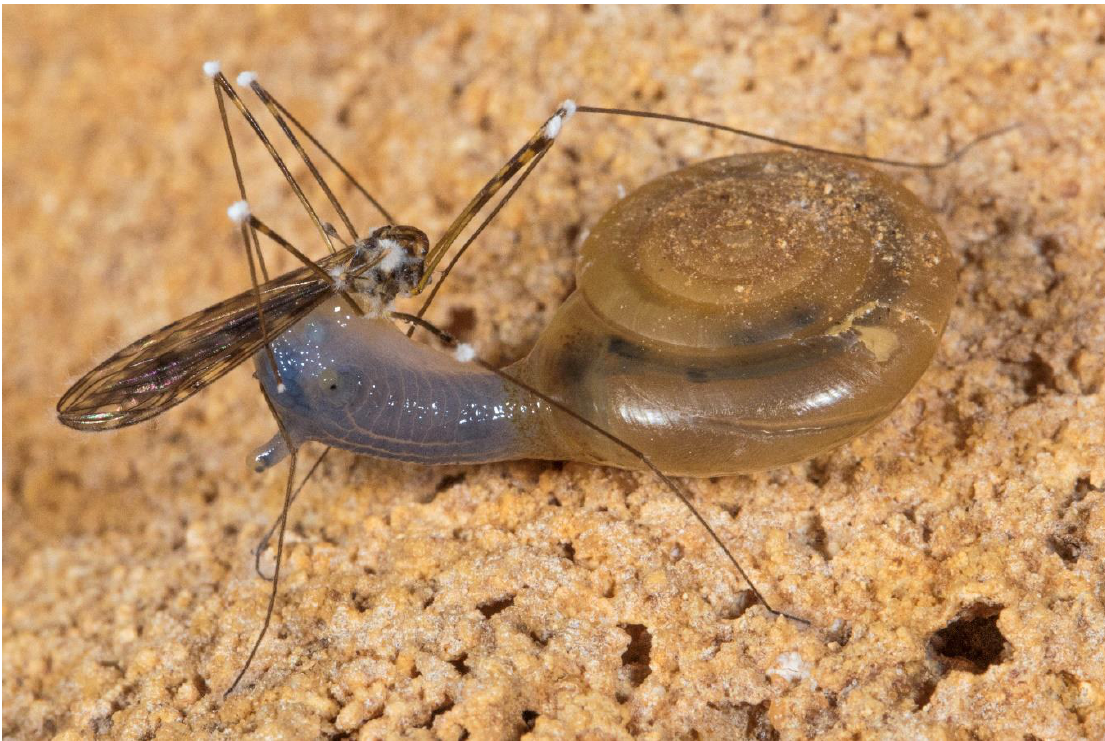
Figure 3. Oxychilus draparnaudi (Beck, 1837), a facultative cave-dwelling snail, feeding on a dead crane fly. In caves, crane flies are not only important for species directly preying on them, but also for the many scavengers. Photo credit: Simone Giachello.